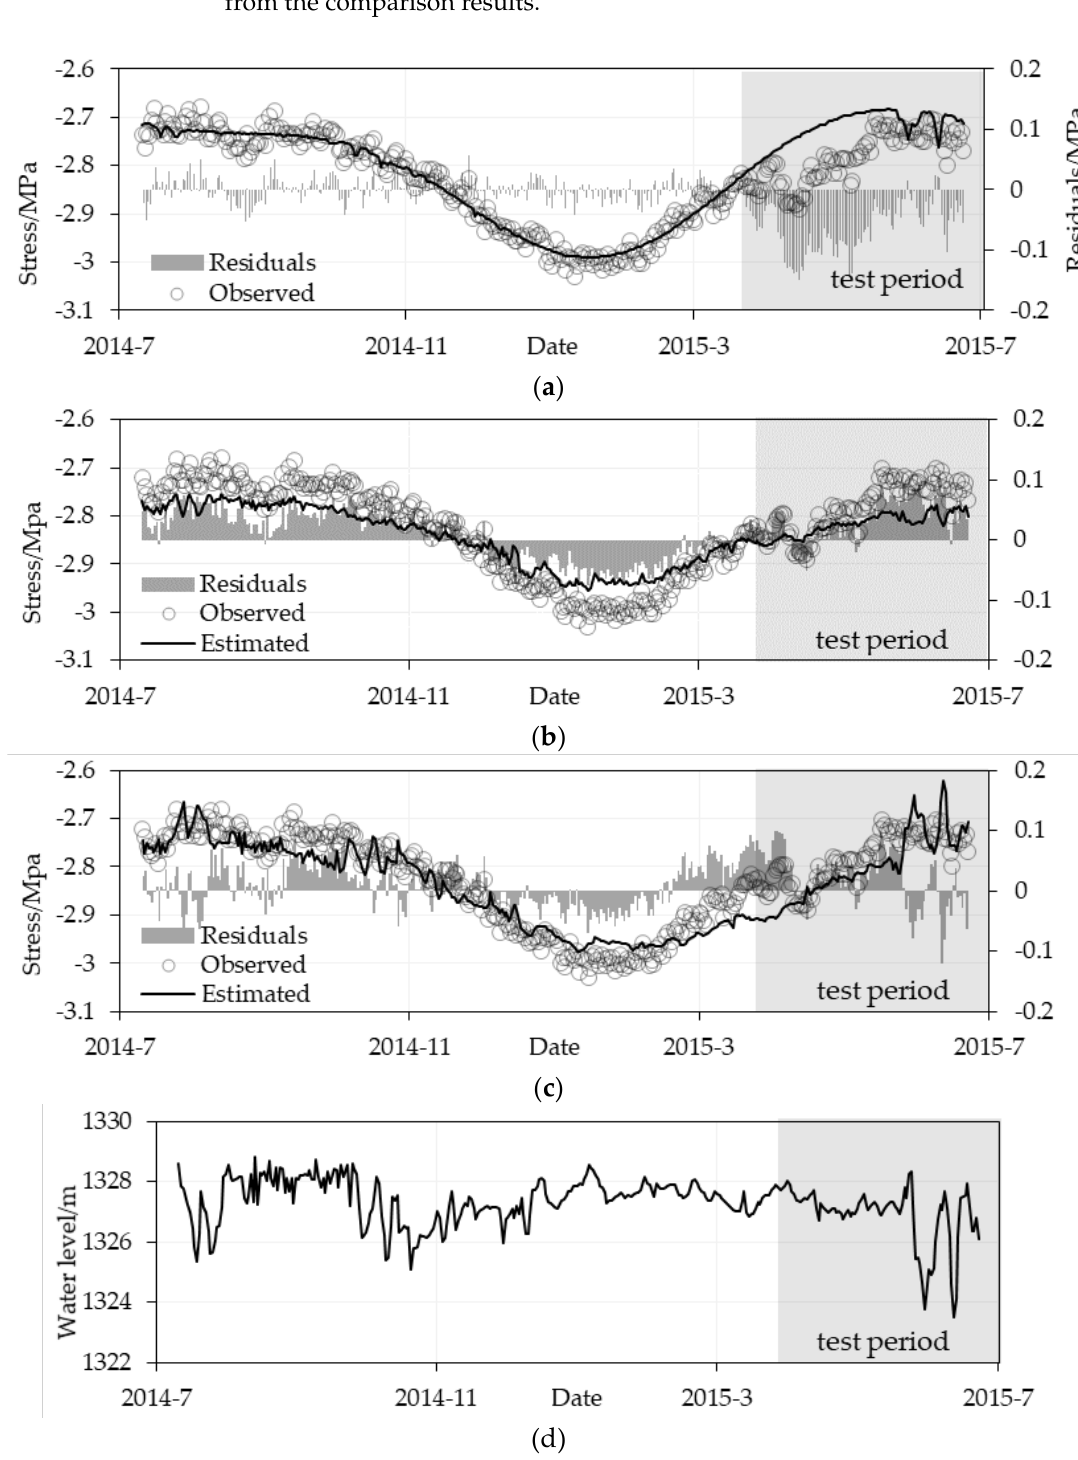
Figure 12. Time curve of each estimation model and water level. Shaded part is the testing period. ( a ) HST. ( b ) SVR. ( c ) NN. ( d ) Time curve of water level. HST: hydrostatic-seasonal-time statistical model; SVR: support vector regression; NN: neural network with single hidden layer.